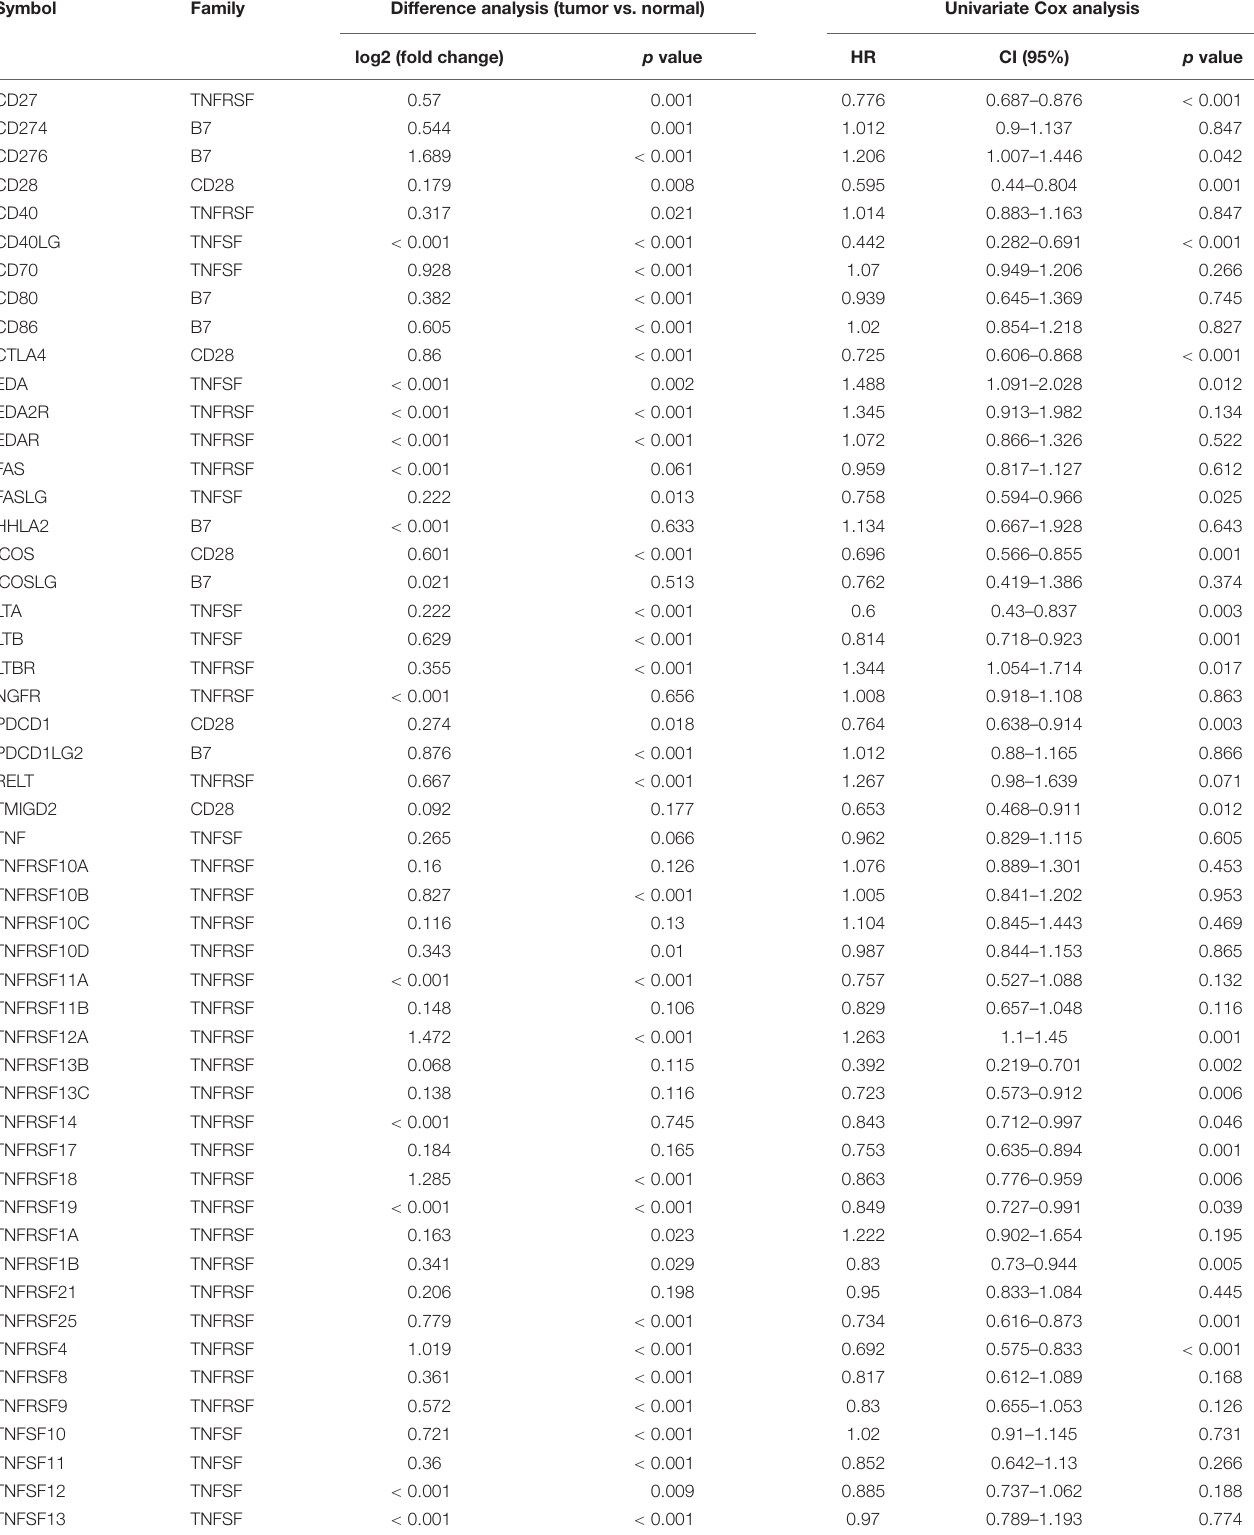
TABLE 2 | Difference analysis and Cox analysis of costimulatory molecule genes in TCGA cohort. Symbol Family Difference analysis (tumor vs. normal) Univariate Cox